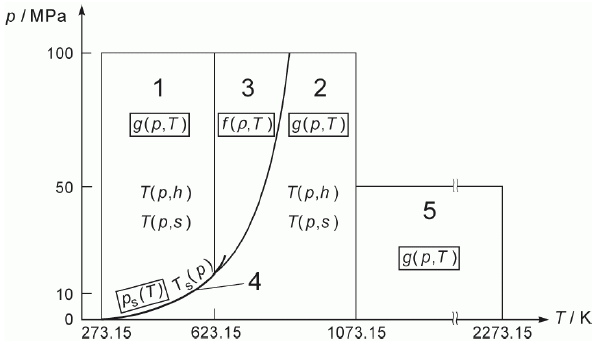
Fig. A2: Thermodynamic relations available from the Industrial Formulation IF-97 (IAPWS, 2007; Wagner and Kretzschmar, 2008) defined in different temperature-pressure regions, derived with reduced accuracy from the IAPWS-95 Helmholtz function for different independent variables. Here we make use of the Gibbs functions “ g ( p, T )” available in region 1 (liquid/fluid) and in region 2 (vapour/fluid) as shown in Fig. A1. In region 3, separate equations for the specific volume are available for various subregions which are not used here. Region 4 is the saturation curve. Graphics reproduced from IAPWS (2007), with permission of IAPWS.